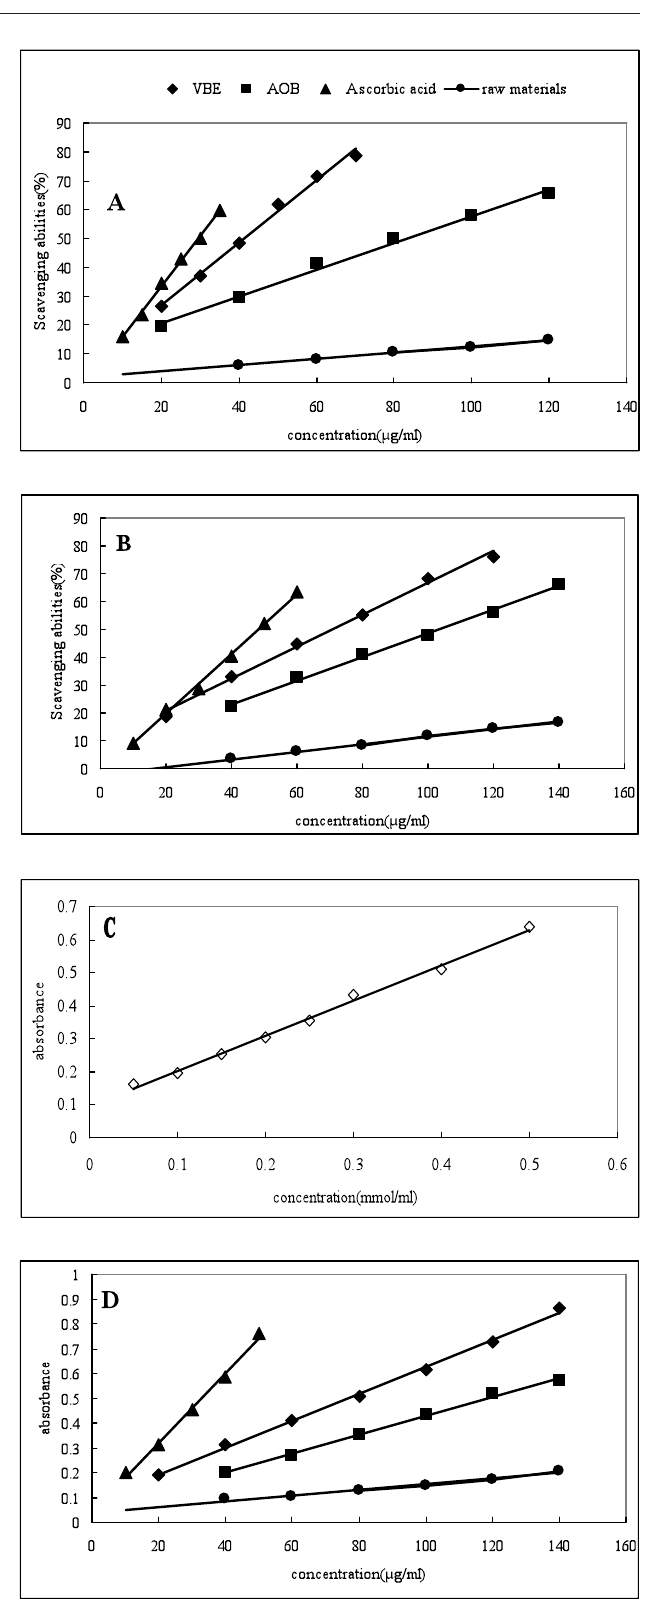
Fig. 2: Antioxidant activities of the raw materials, VBE, AOB and ascorbic acid. (A) DPPH radical scavenging assay; (B) ABTS radical scavenging assay; (C) FRAP-FeSO 4 standard curve; (D) Different concentration samples absorbance curve in FRAP as - say. The value in the figure is average value, n =